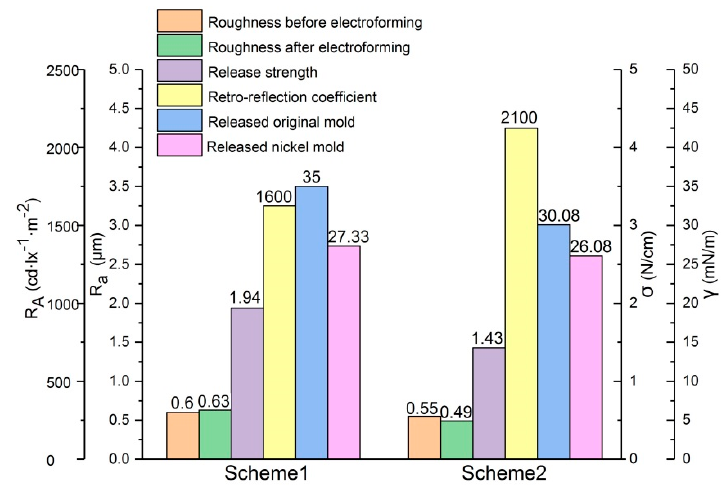
Figure 10. Comparison of the results of the two experiment schemes.